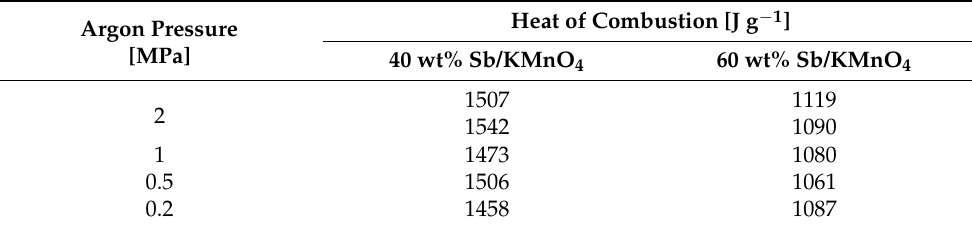
Table 2. Influence of argon pressure on the heat of combustion for selected Sb/KMnO 4